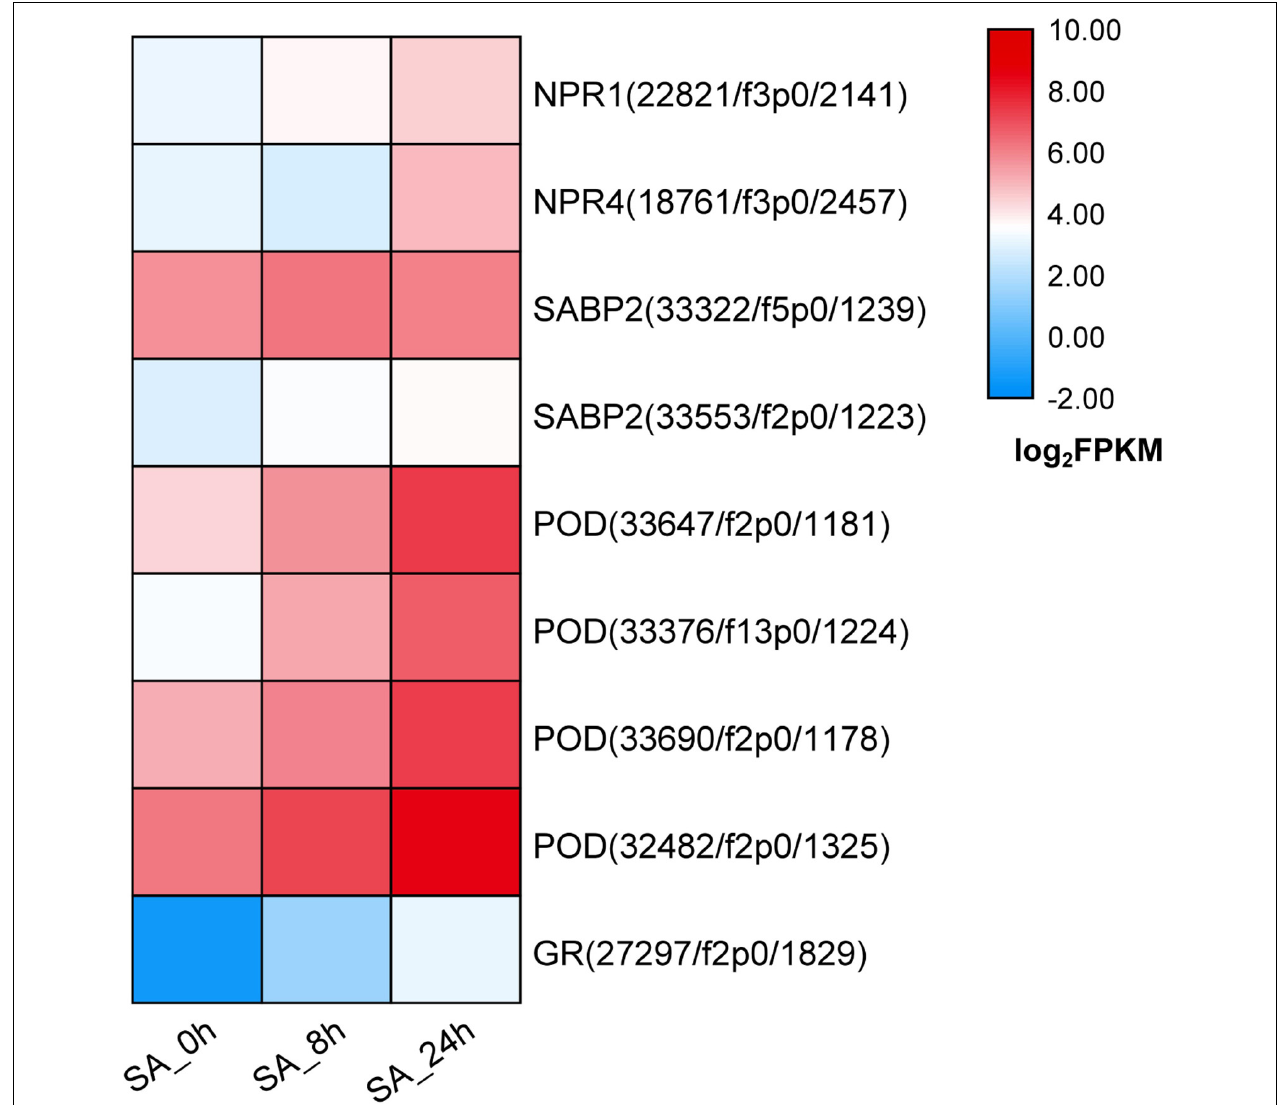
FIGURE 5 | Expression of candidate genes involved in SA signaling network. The heat graph shows the up-regulated genes encoding SA-binding proteins and reactive oxygen species (ROS) scavenging enzymes under SA treatments. The fragment per kilobase per million (FPKM) for unigenes were log 2